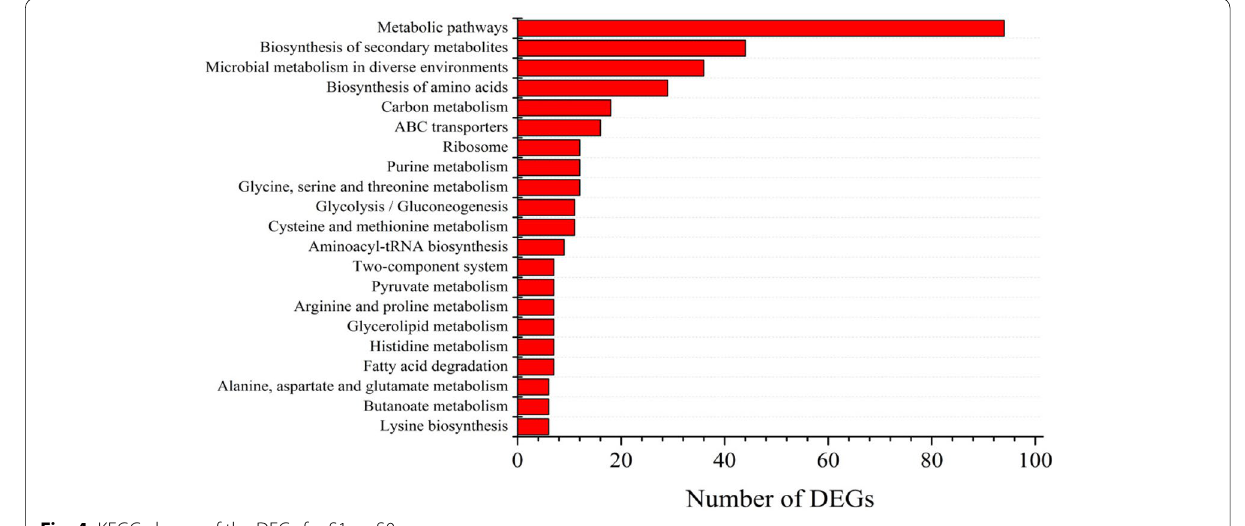
Fig. 4 KEGG classes of the DEGs for S1 vs. S0